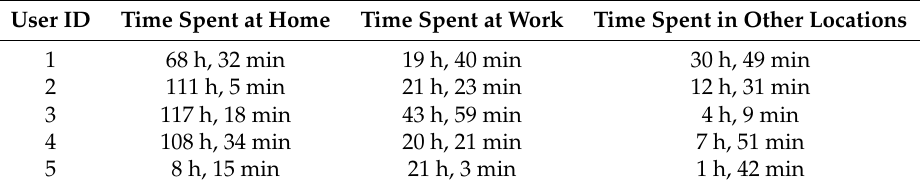
Table 3. Time spent in all